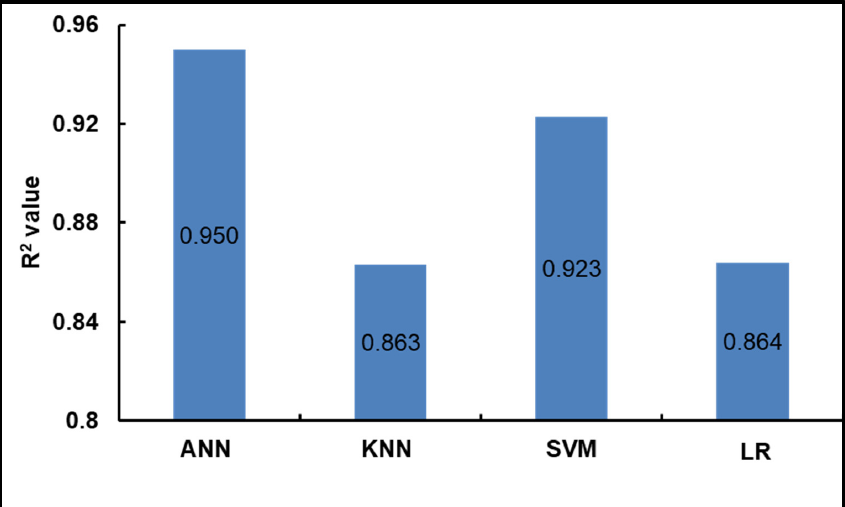
Figure 13. R ‐ squared comparison for the different ML model. Figure 13. R-squared comparison for the different ML